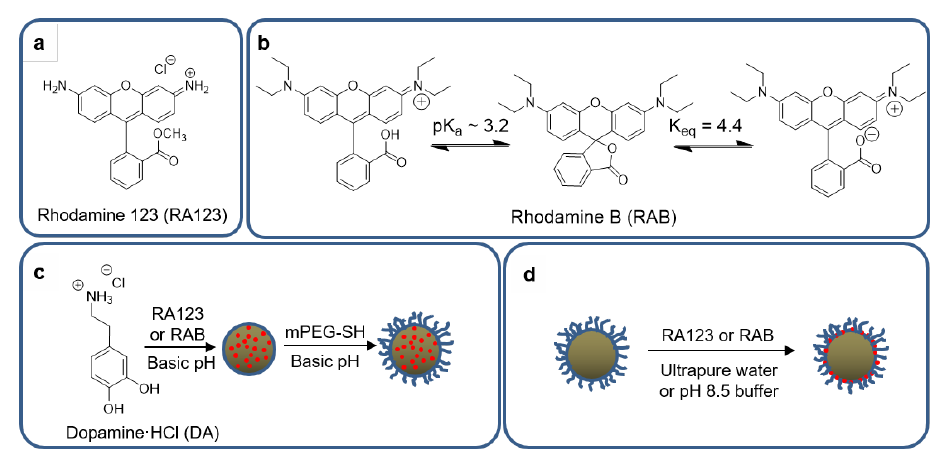
Figure 5. Approaches to synthesis of fluorescent MMNPs. ( a ) Structure of rhodamine 123 (RA123). ( b ) Structures of rhodamine B (RAB), including the fluorescent cationic acid, non-fluorescent neutral lactone, and fluorescent zwitterionic structures. ( c ) In situ approach and subsequent PEGylation: